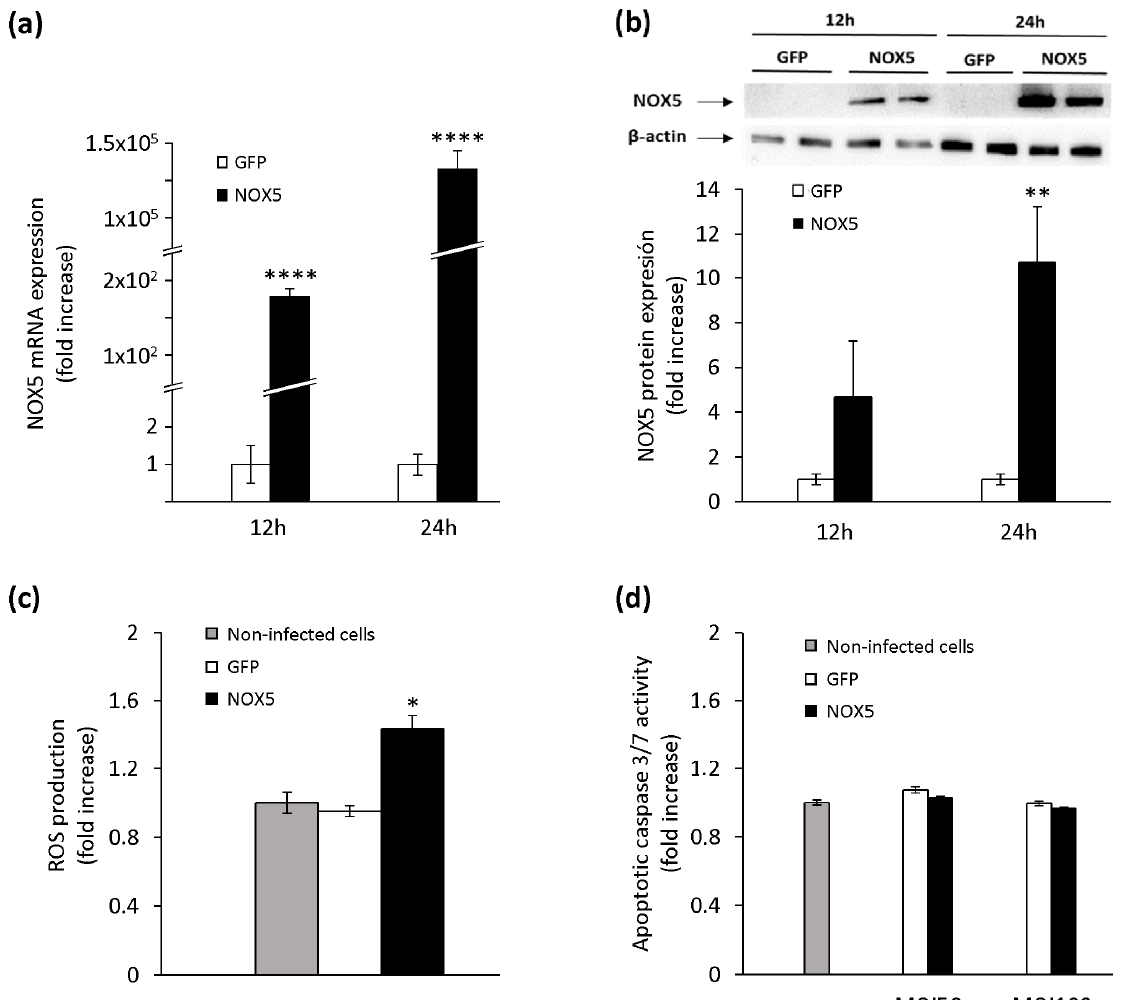
Figure 1. Characterization of NADPH oxidase (NOX)5- β overexpression in TeloHAEC cells infected with NOX5- β and control Green Fluorescent Protein (GFP) adenoviruses. ( a ) NOX5 mRNA levels after 12 and 24 h of infection. n = 6. **** p < 0.0001 vs. GFP. ( b ) Representative NOX5 and β -actin immunoblots of cells after 12 and 24 h of infection, and quantification of the NOX5 protein. n = 4. ** p < 0.01 vs. GFP. ( c ) ROS production of non-infected cells and cells infected with GFP or NOX5- β adenoviruses. n = 6. * p < 0.05 vs. non-infected and GFP-infected cells. ( d ) Apoptotic levels of non-infected cells and cells infected with GFP or NOX5- β adenoviruses at different multiplicity of infections (MOIs). n = 6.